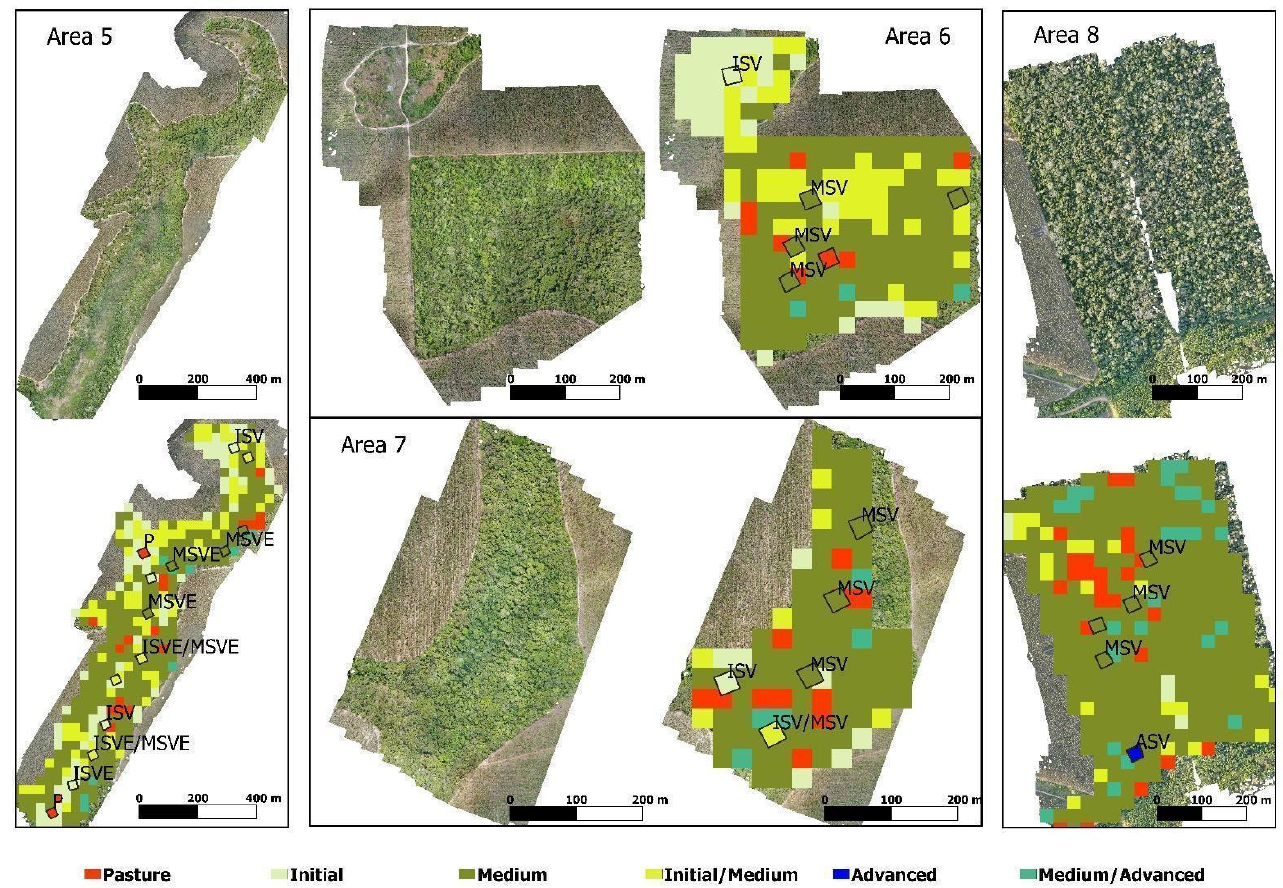
Figure 14. Spatialization of succession stage estimation for areas 5 to 8 based on DAP-UAV point clouds.